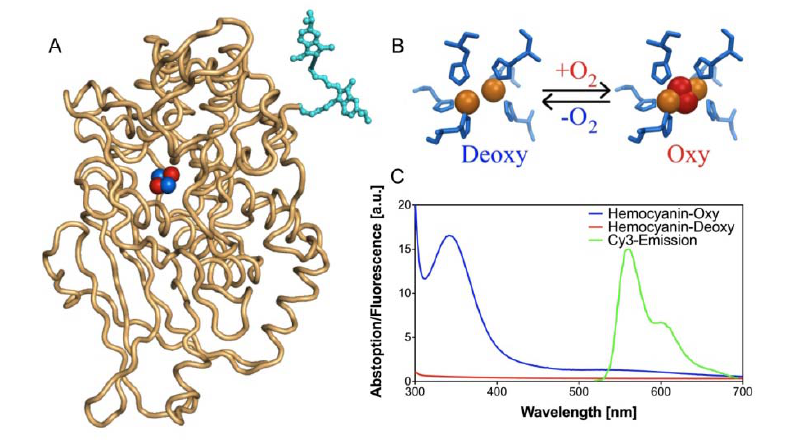
Figure 1. (A) Representation of Cy3-labeled hemocyanin. The Cy3 dye (cyan) is showed attached to the end terminus of a monomer hemocyanin. (B) Detail of hemocyanin active site showing the active site histidines (blue), copper ions (orange) and the binding oxygen molecule (red). (C) The absorption spectra of the deoxygenated (red) and oxygenated (blue) forms of hemocyanin together with the emission spectrum of Cy3